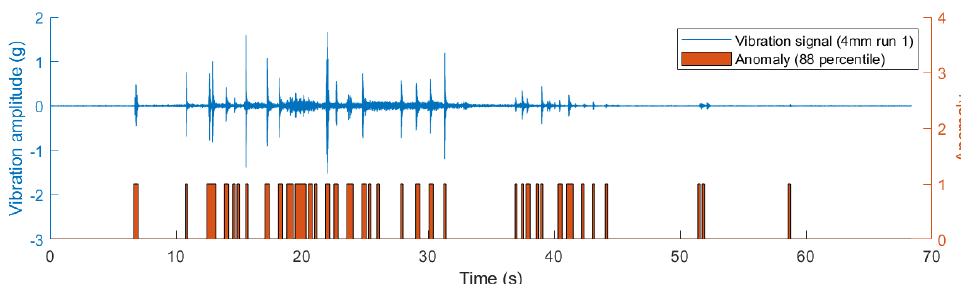
Figure 11. Knee point search for finding the threshold.